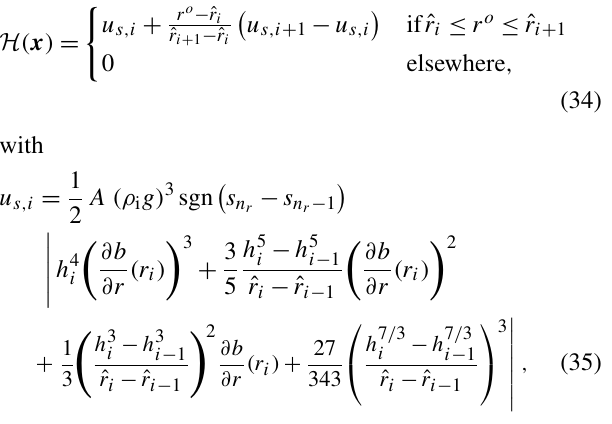
Figure 2. Ice thickness profile from the reference run in a simple case (flat bedrock, EISMINT surface mass balance from Eq. A1). The initial state follows the profile of Eq. (37) with h 0 = 2000m and r max = 450km. The reference run is obtained with an initial mesh of n r = 28 points evenly spaced between ˆ r 1 = 0 and ˆ r n